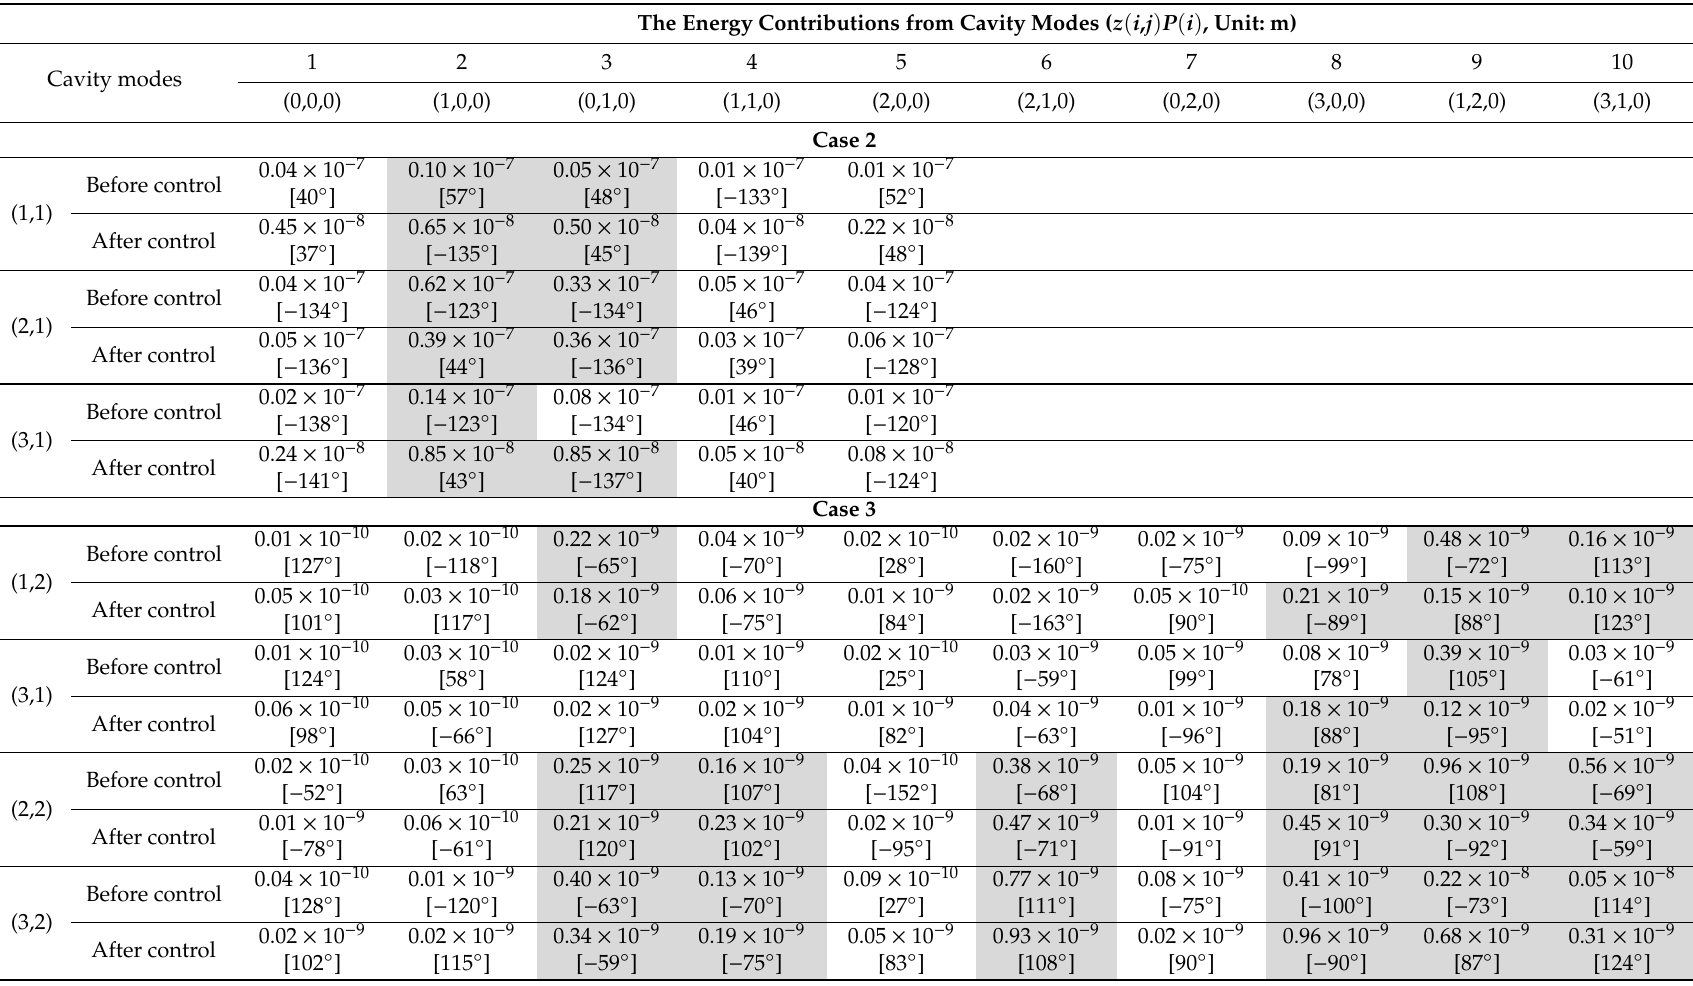
Table 6. The energy contributions of the cavity modes to the base plate B modes. The Energy Contributions from Cavity Modes ( z ( i , j ) P ( i ) , Unit: